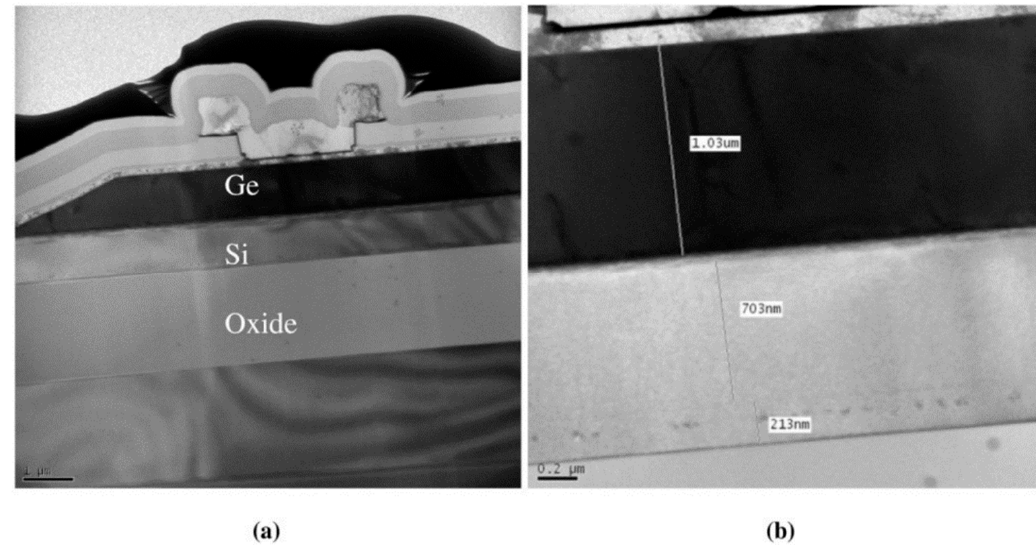
13 of 54 Figure 13. Cross-section schematic of Ge/Si mesa type APD structures (Si 3 N 4 was utilized for pas- sivation and planarization) Different from previously reported mesa-type Ge/Si APD, Ning Duan et al. [69] adopted selective epitaxial growth (SEG) to form the Ge absorption layer and the Si mul- tiplication layer. On the one hand, SEG Ge growth was able to reduce the device pro- cessing complexity; on the other hand, it can also prevent the mesa edge breakdown. Growth procedures for SACM Ge/Si APD are as follows: (I) high-resistivity (100) SOI sub- strates with 220 nm Si layer and 2000 nm buried oxide; (II) bottom n-type Si contact for- mation: As ion implantation; (III) SEG growth of 700 nm Si multiplication layer at 600 °C; (IV) p-type charge layer formation: implanting B into the as-grown Si; (V) SEG growth of 1000 nm Ge absorption layer: including 50 nm SiGe buffer, 50 nm Ge seed layer growth at